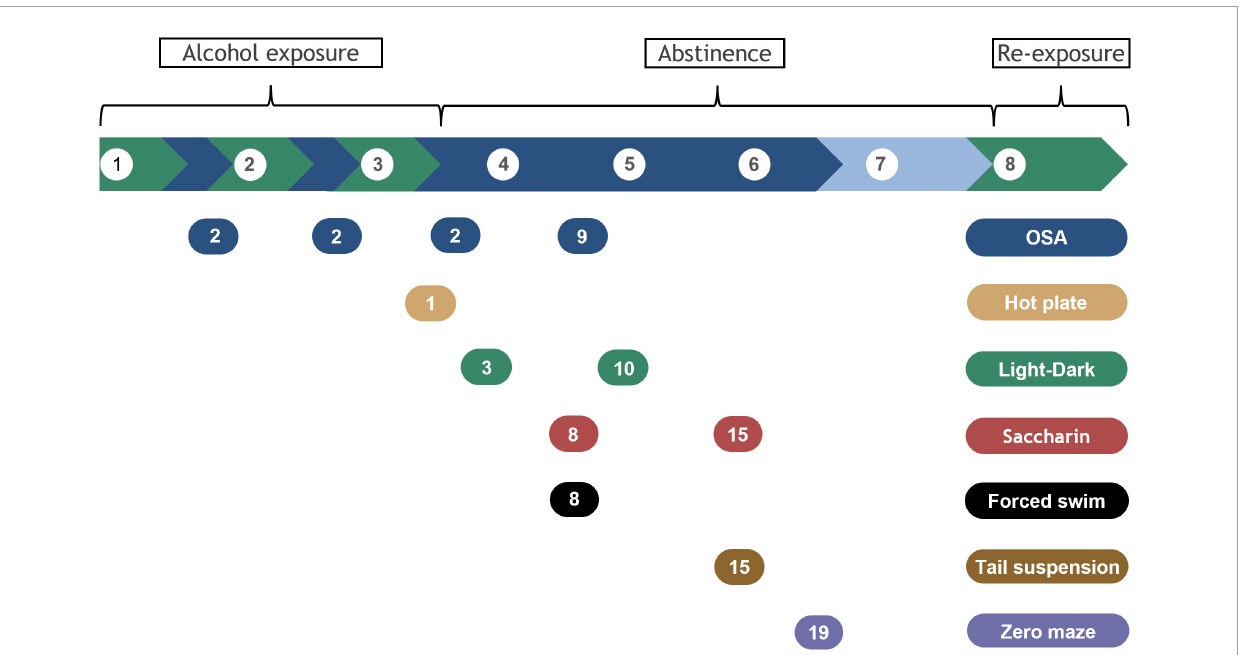
FIGURE1 Timeline for alcohol exposure, abstinence, and behavioral assays. Alcohol exposure is highlighted in green and withdrawal periods in blue. Break phase is indicated in lighter blue. Brackets indicate alcohol exposure or abstinence phases and alcohol re-exposure before samples collection. Behavioral tests are indicated by the colored bubbles, with the testing day specified inside, counted as days of forced abstinence within each specific withdrawal period. White bubbles represent week